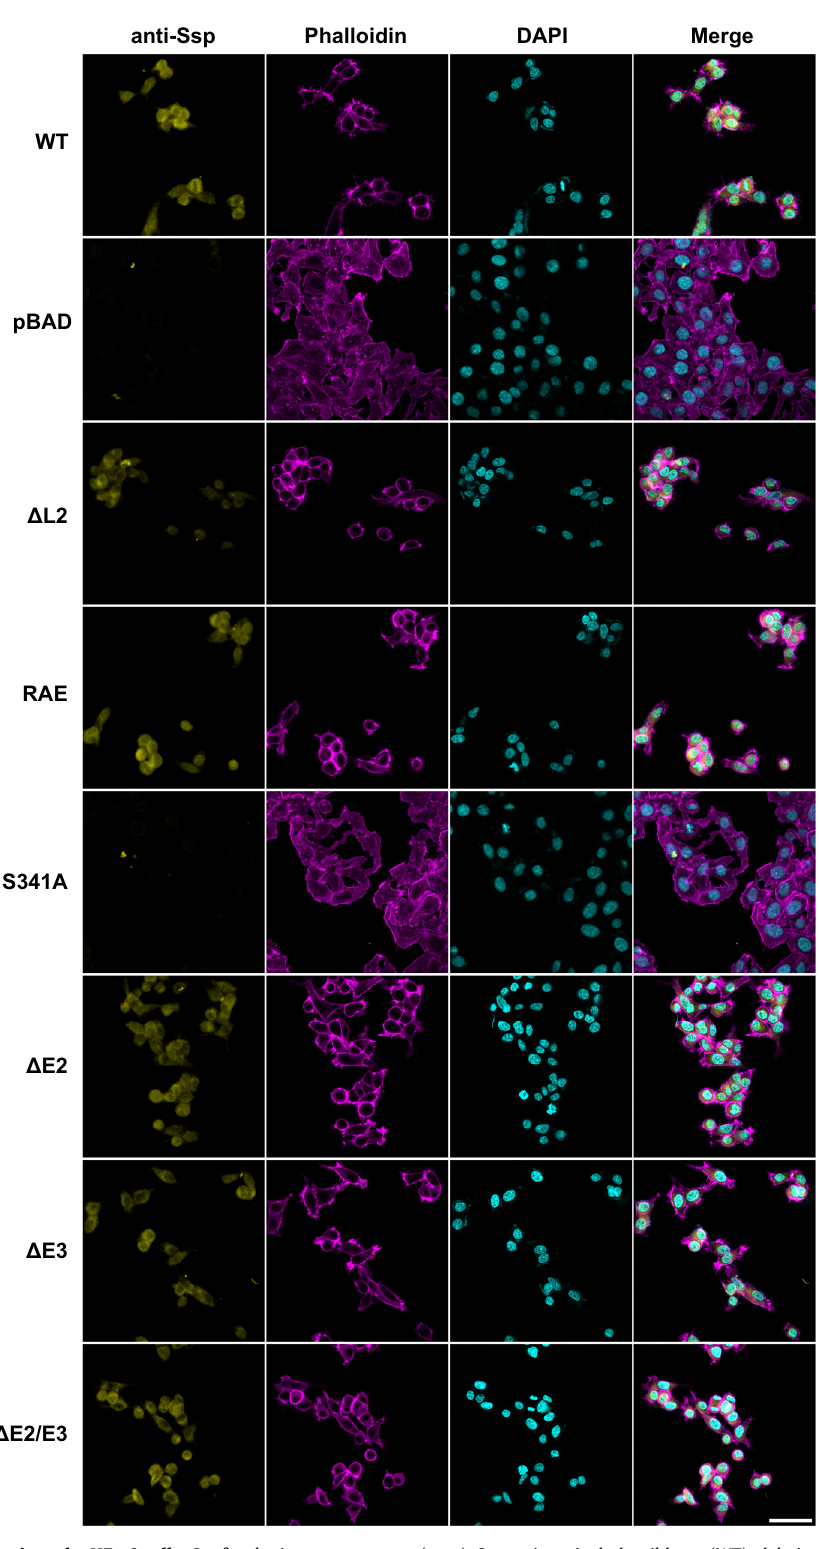
(cyan). Ssp variants include wildtype (WT), deletions of Loop 2 ( Δ L2), deletion of active site protrusions E2 and E3( Δ E2, Δ E3, Δ E2/ Δ E3),and site-directed mutants of theactivesiteSer(S314A)andRGDmotif(RAE).pBADdenotesvectoronlycontrol. Images are representative of cells observed from at least three independent experiments. Scale bar represents 50 μ